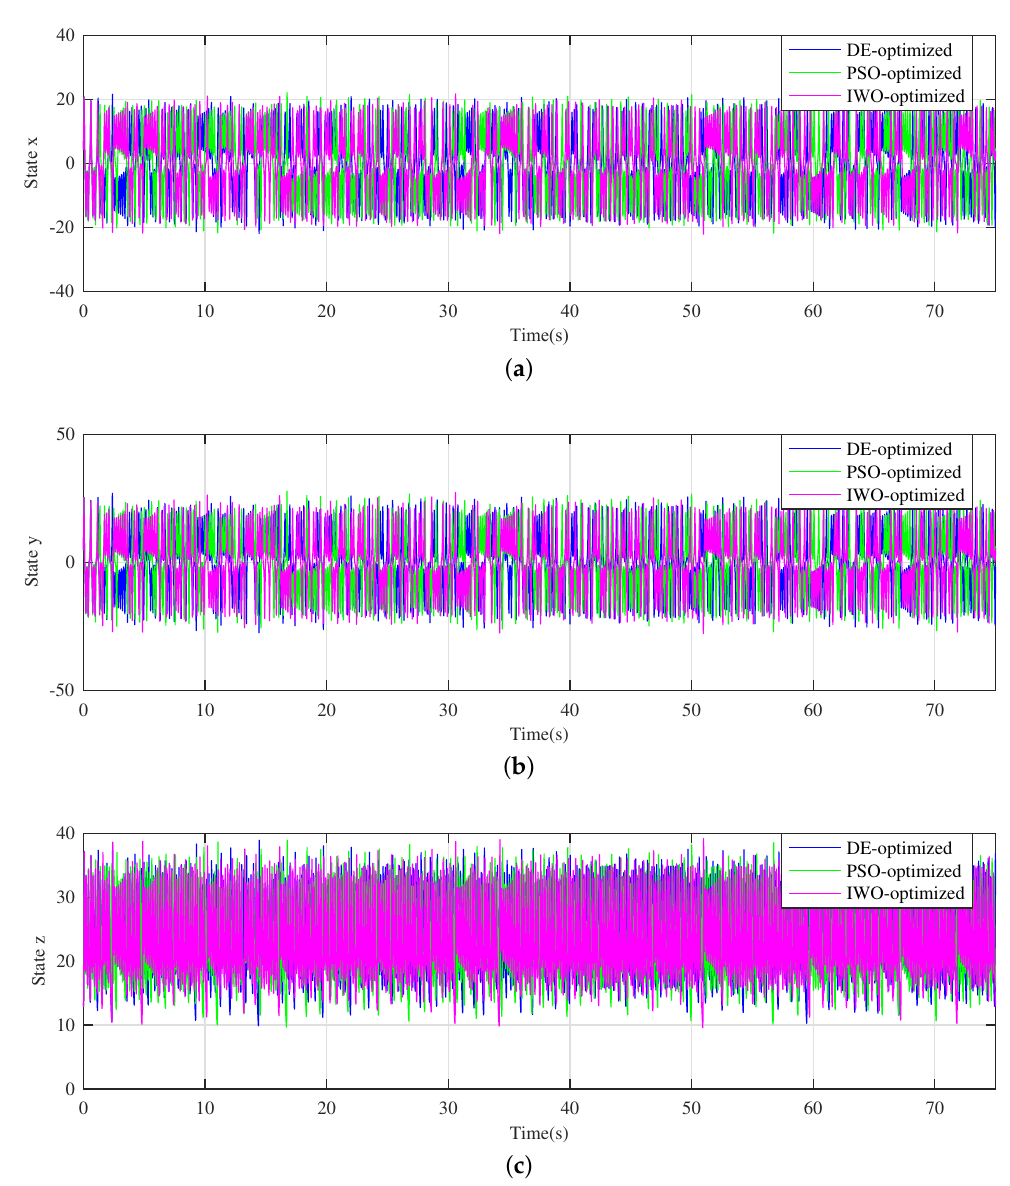
Figure 2. Timeseries of the optimized fractional order chaotic Chen systems. Each state of the optimized system is superimposed in the respective graph, as indicated by the legend. ( a ) State x ( b ) State y ( c ) State z